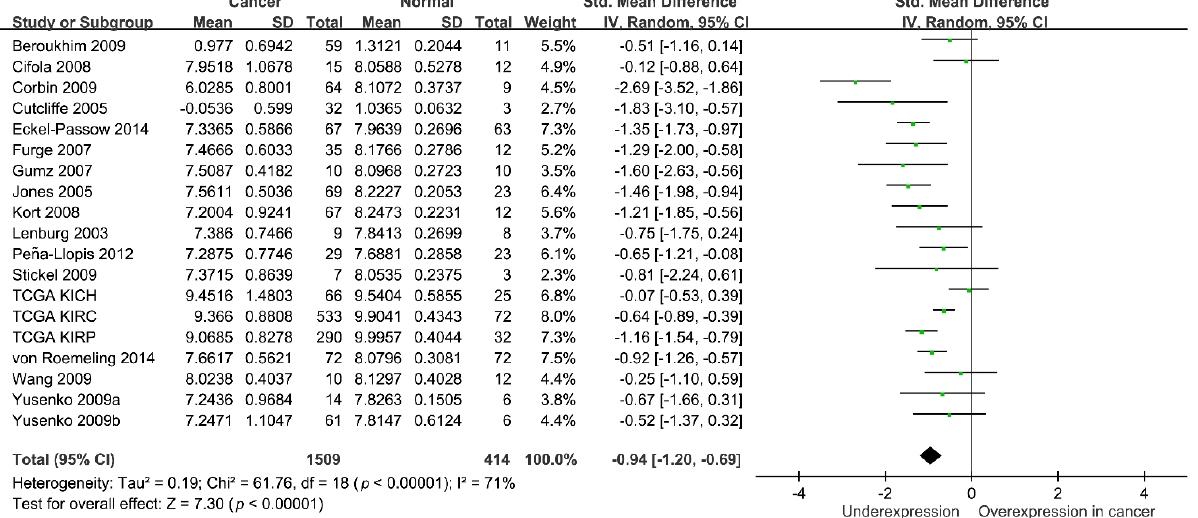
Figure 2. Pooled analysis of SHANK2 expression levels between cancer and normal tissues in 19 independent kidney cancer studies. Std., standardized; SD, standard deviation; IV, inverse variance; CI, confidence interval; df, degrees of freedom.